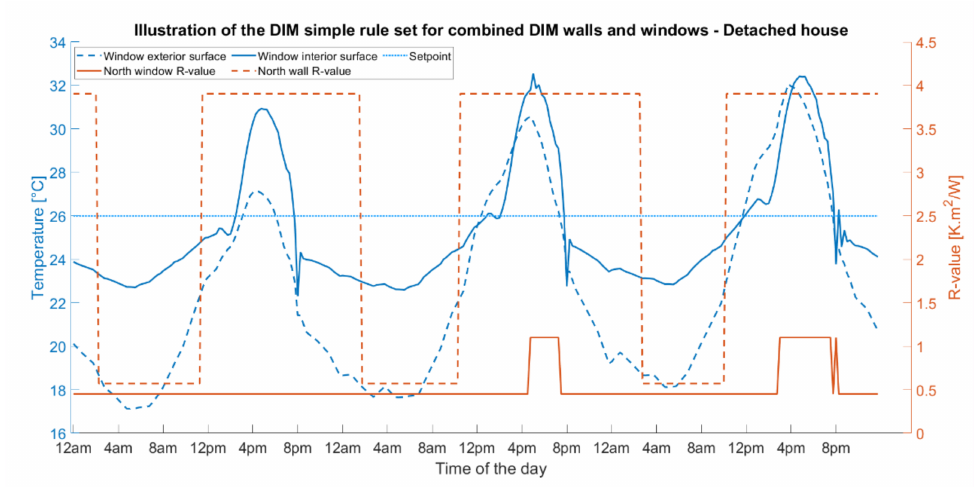
Figure 13. Performance of combined SIS walls and windows during the period between 22 July to 24 July for the prototypical detached house located in Barcelona, Spain. For SIS walls and dynamic windows, high R-value = 3.9 m 2 · K/W; low R-value = 0.49 m 2 · K/W. For SIS windows, high R-value = 1.1 m 2 · K/W; low R-value = 0.45 m 2 · K/W; high SHGC = 0.4; low SHGC =